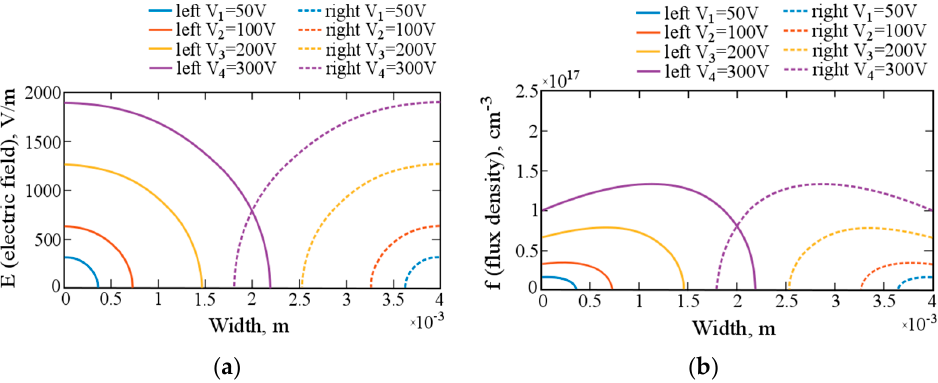
Figure 6. ( a ) Electric field distribution in the cross-section of the crystal during the double-sided drift process. ( b ) The flux density of lithium-ions in the crystal during the double-sided drift process.